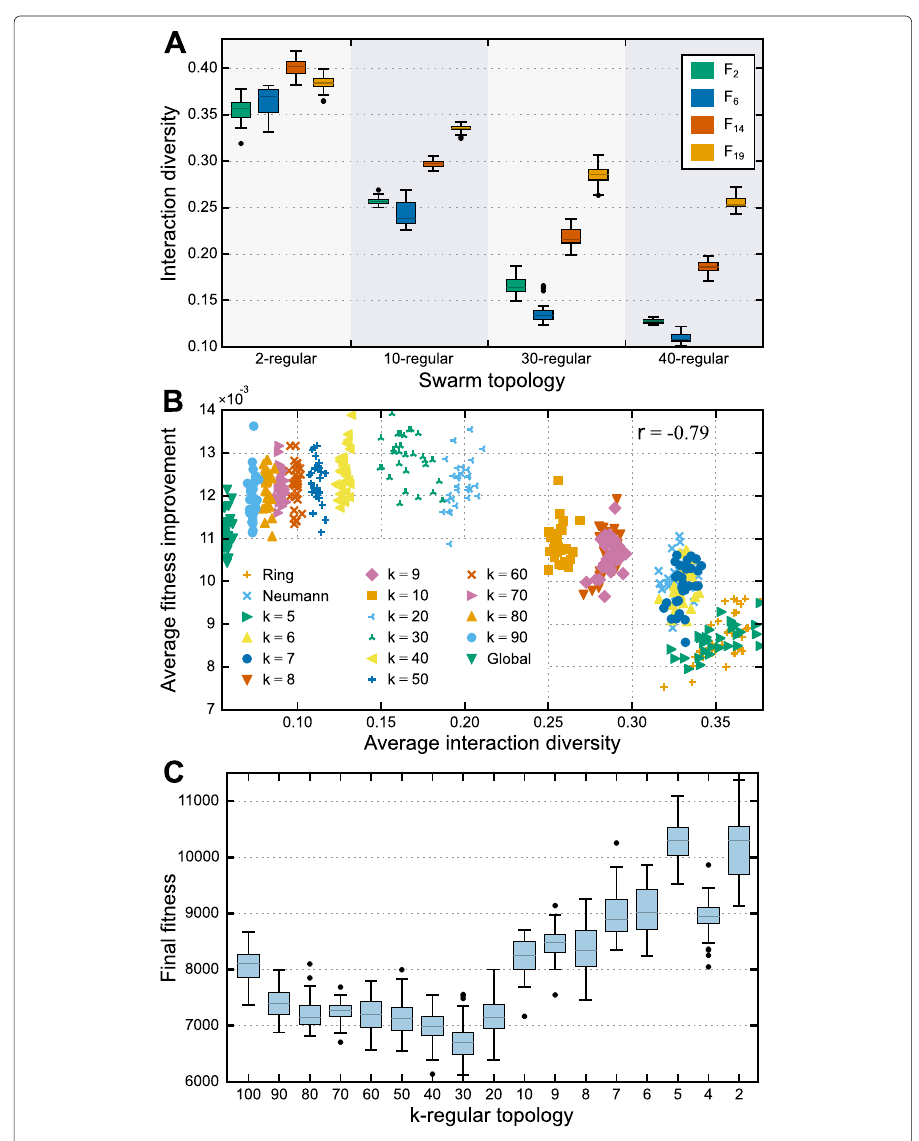
Fig. 8 The interaction diversity, fitness improvement, final fitness, and k -topologies are associated in a non-trivial manner. ( a ) Some benchmark functions appear to consistently present higher interaction diversity when compared to other regardless of the underlying communication topology. In the results for F 6 function, ( b ) although the correlation of − 0.79 indicates a strong negative linear relationship between the average interaction diversity and the mean fitness improvement, one can easily see that they are associated in a non-monotonic way. ( c ) Similarly, the final quality of the fitness found by the swarm also presents a non-monotonic behavior regarding k -regular topologies and consequently, interaction diversity